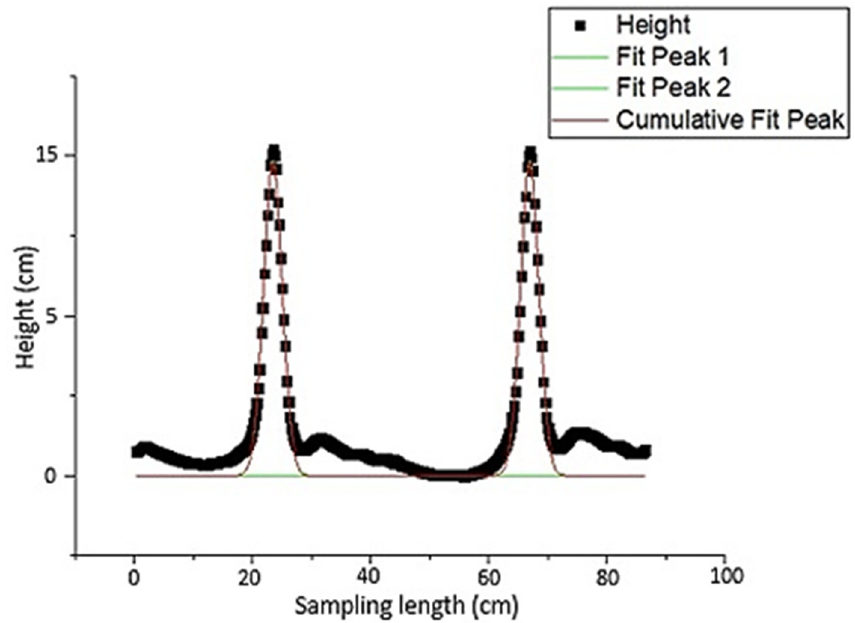
Figure 9. Corresponding peak fitting for two plow layers based on height profile.